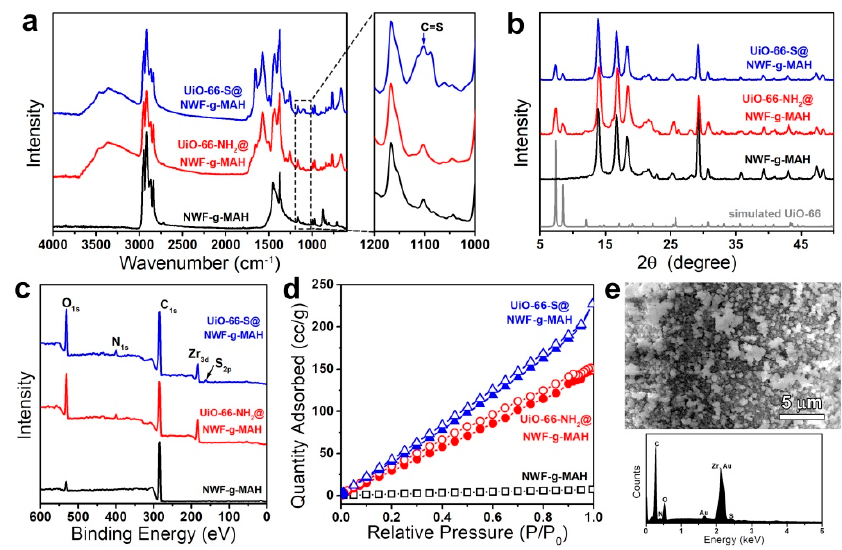
Figure 1. The characterization of US-Ns, ( a ) ATR-FTIR, ( b ) XRD, ( c ) XPS, ( d ) N 2 isothermal adsorption curve, ( e ) SEM image and EDS spectrum; the scale bar is 5 μ m.